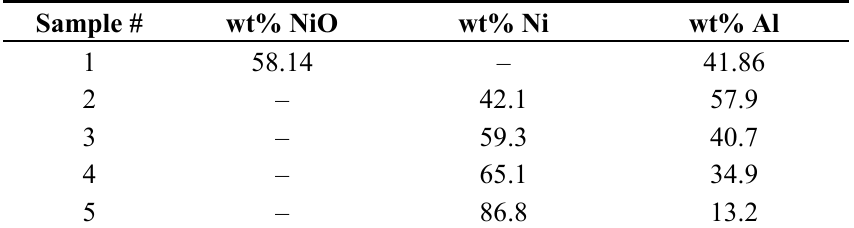
Table 3. The five samples made by mixing the